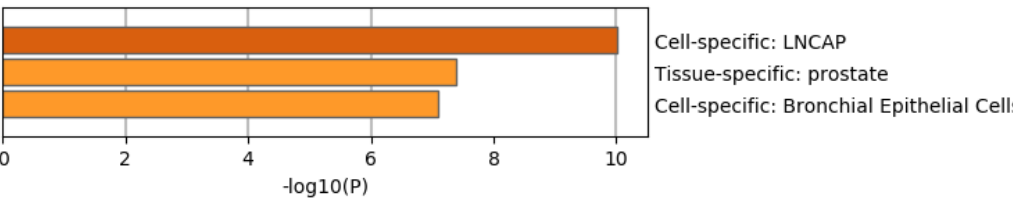
Figure 7. Summary of enrichment of the DisGeNet category of Metascape when 1785 protein-coding genes included in 1447 genomic regions selected by TD-based unsupervised FE are considered.